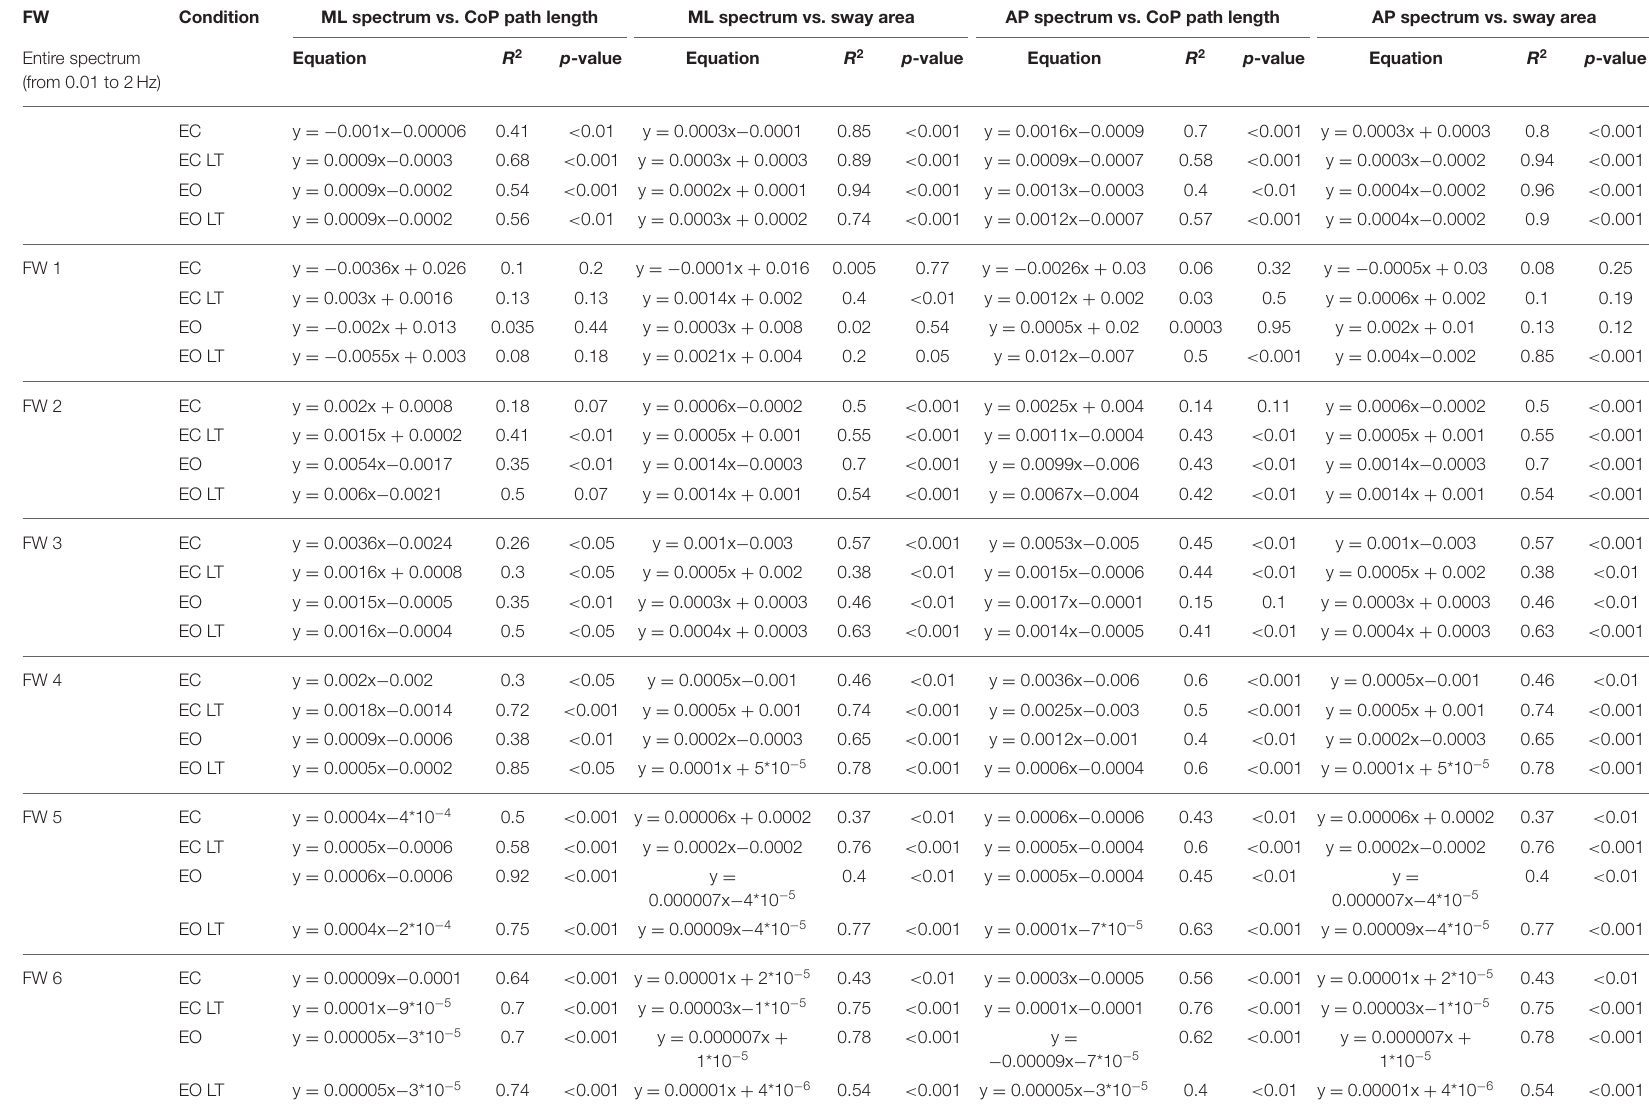
TABLE 1 | Relationship between level of mediolateral (ML, left part) and anteroposterior (AP, right part) spectrum and CoP path length and sway area. ML spectrum vs. CoP path length ML spectrum vs. sway area AP spectrum vs. CoP path length AP spectrum vs. sway